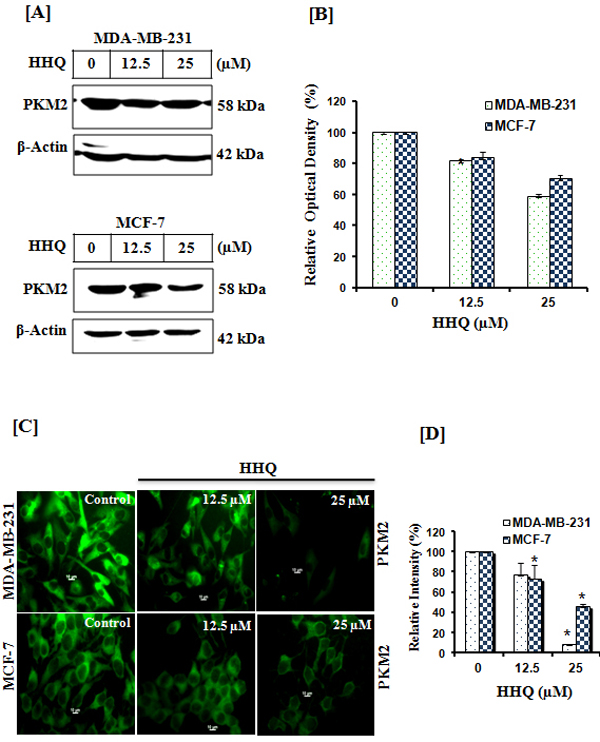
Expression analyses of glycolytic enzyme pyruvate kinase-muscle 2 (PKM2) in response to HHQ treatment in human breast cancer cell, MDA-MB-231 and MCF-7. The breast cancer cells were treated with 12.5 μM and 25 μM of HHQ for 48 h at 37 °C. Representative western blot hybridization signals for PKM2 [A] and the quantitation of the signals is shown in [B]. Immunofluorescent detection of PKM2 is shown in [C] and the relative intensity measurement of immunofluorescence is shown in [D]. Significant decrease in PKM2 expression was observed in HHQ treated cells. Data are representative of three independent experiments done in triplicates and expressed as mean ± S.E.M. ''*'' represents the statistical significant (p<0.05) difference between control and HHQ treated groups.